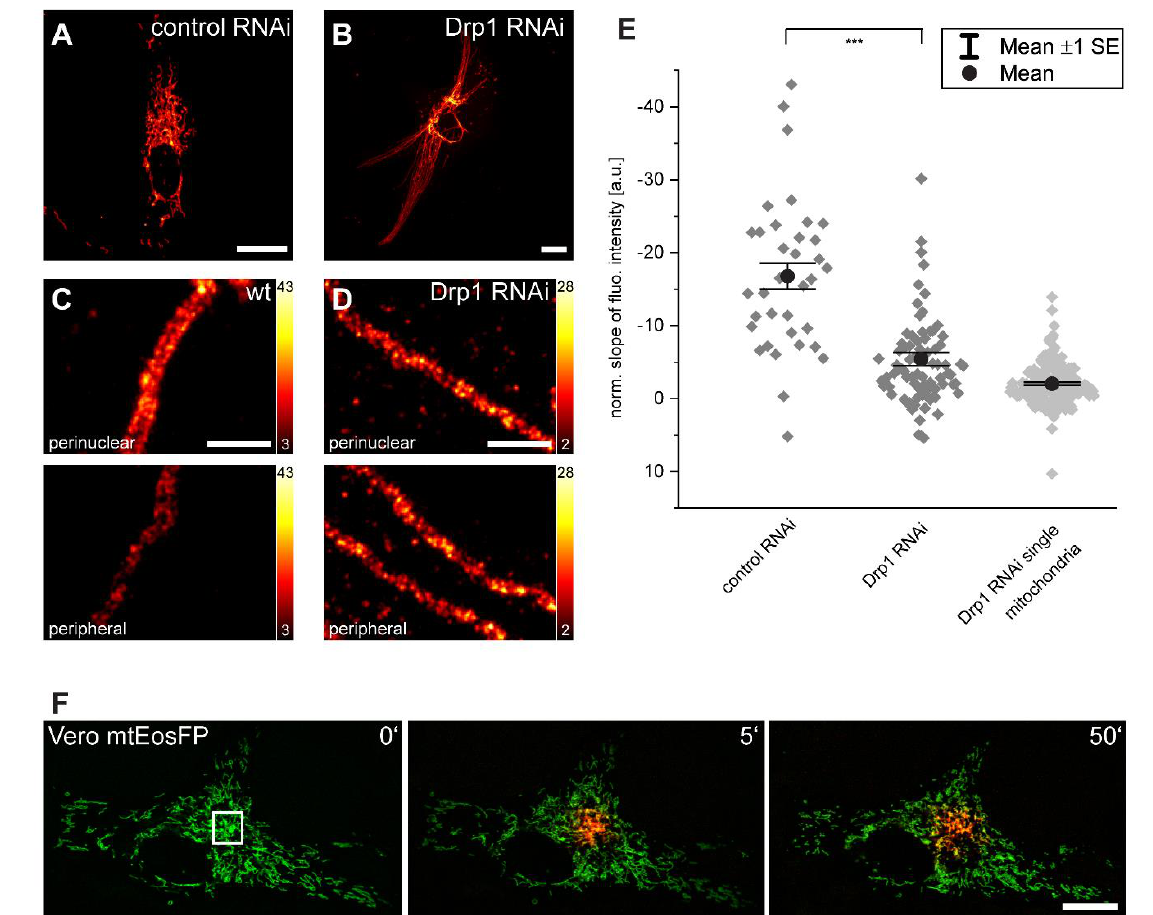
Figure 4. Inhibition of mitochondrial fission reduces inner-cellular Tom20 protein abundance gradients. ( A , B ) RNAi-mediated knockdown of Drp1 leads to the elongation of mitochondria and the hyperfusion of the mitochondrial network. ( C , D ) Representative STED images of perinuclear and peripheral mitochondria in control ( C ) and Drp1-knockdown ( D ) cells labeled with a Tom20 antibody. Normalized slopes of the fluorescence intensity gradients of control and of Drp1-knockdown cells, and of single mitochondria in Drp1-knockdown cells decorated with antiserum against Tom20. ( E ) For the analysis, overlapping mitochondria were excluded. *** P = 0.001 (paired t test analysis). Each dark grey rhomb (control RNAi and Drp1 RNAi) represents one cell; each light grey rhomb (Drp1 RNAi single mitochondria) represents one mitochondrion. Black dot: mean. Error bars: standard error of the mean. Live-cell confocal imaging of Vero cells expressing mitochondrial matrix targeted mtEosFP. ( F ) At t = 0 min in the indicated area, the green fluorescent mtEosFP was photoconverted into its red fluorescent form. Subsequently, the spreading of the photoconverted mtEosFP was recorded. Scale bars: 1 µm ( C , D ), 20 µm ( A , B , F ).